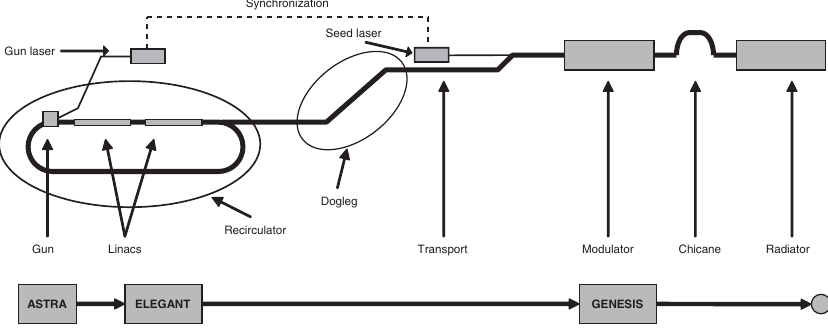
FIG. 1. Schematic view of the FEL setup and simulations.